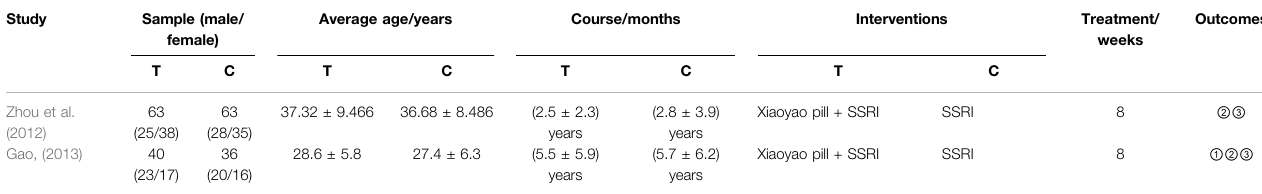
Frontiers in Pharmacology |